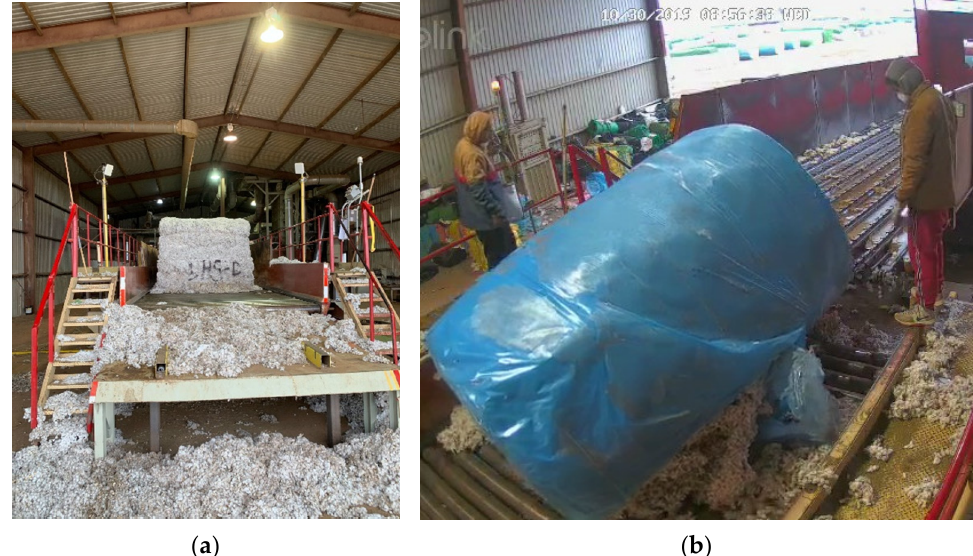
Figure 1. Module feeder floor system ( a ) and unloading of round module onto the module feeder floor ( b ) where a module accidentally tipped over, trapping plastic underneath it. Whenever this situation occurred, the gin crew was not completely able to remove all of the plastic before it went into the gin. entrained onto the module feeder dispersing cylinders, as shown in Figure 2.